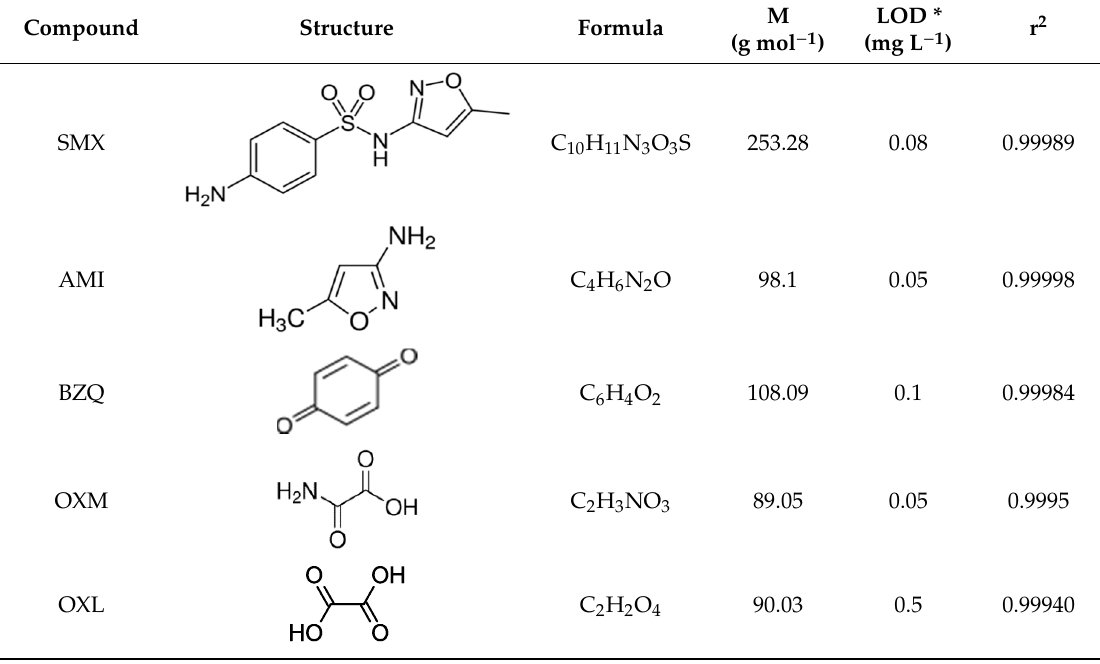
Table 1. Characteristics of sulfamethoxazole (SMX) and intermediate compounds mentioned in this work. work. this work. work.